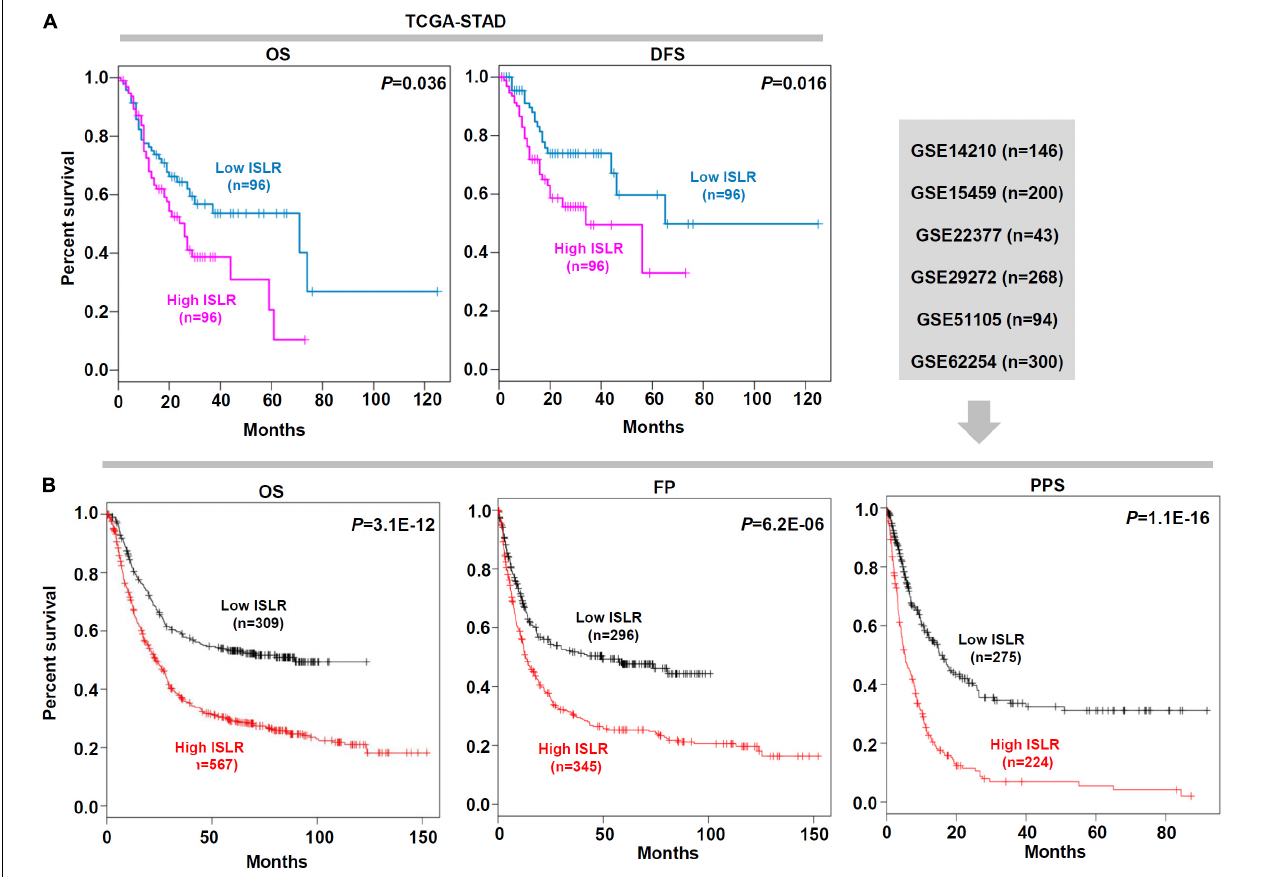
FIGURE 2 | Survival curve analysis of the ISLR gene for gastric cancer cases. (A) Overall survival (OS) and disease-free survival (DFS) analyses according to the expression level of the ISLR gene were performed using gastric cancer cases in the TCGA-STAD cohort. (B) Based on the data of gastric cancer cases in GSE14210, GSE15459, GSE22377, GSE29272, GSE51105, and GSE62254, we also performed OS, first progression (FP), and post progression survival (PPS) analyses through Kaplan–Meier